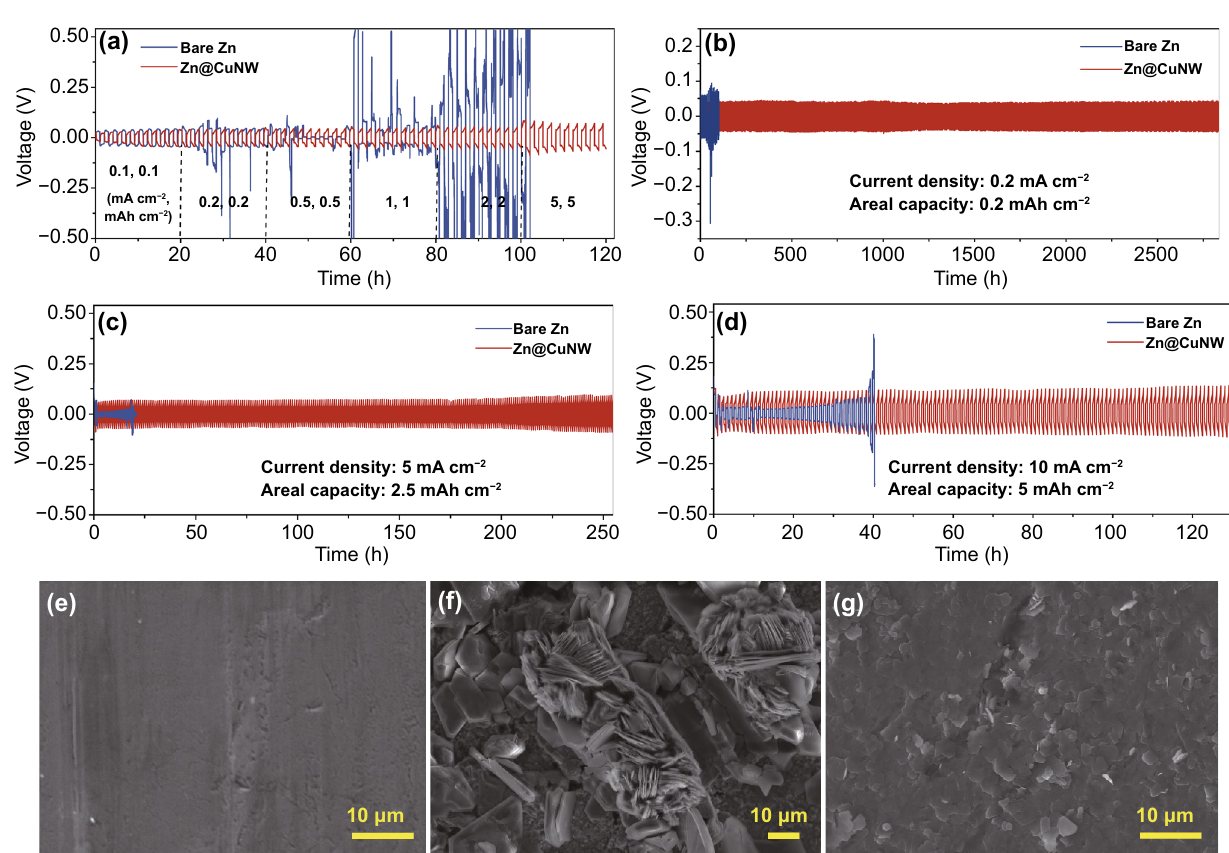
Fig. 2 a Rate performance of the symmetric cells with bare Zn foil electrodes and Zn@CuNW electrodes. Cycling stability of the symmetric cells at various current densities and areal capacities: b 0.2 mA cm −2 and 0.2 mAh cm −2 ; c 5 mA cm −2 and 2.5 mAh cm −2 ; d 10 mA cm −2 and 5 mAh cm −2 . SEM images of e pristine Zn foil, f bare Zn foil after cycling for 100 h, and g protected Zn foil after cycling for 100